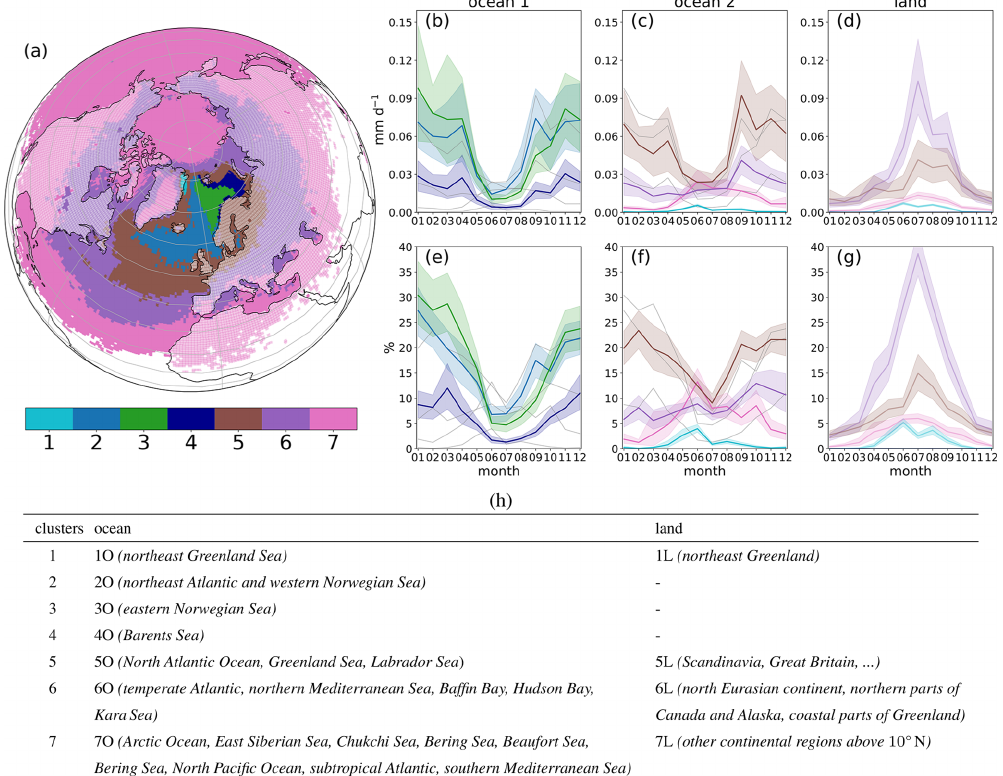
Figure 8. (a) K -means clustering with additional manual separation. The annual cycle of moisture sources contributing to precipitation in the study region is plotted for each cluster in (b) – (d) as absolute number and in (e) – (g) as relative number in percent of the total diagnosed moisture source amount. The ocean (with sea ice) regions in (b) , (c) , (e) , and (f) are separated from the land regions in (d) and (g) , and land regions have more transparent colours in (a) . We use two graphs for the ocean regions for readability; grey lines in (b) , (c) , (e) , and (f) correspond to the missing ocean regions for comparison. Shaded areas represent the 95% confidence interval of the mean. Summing up the different regions of relative contribution for ocean (e, f) and for land (g) would give the total land or ocean (with and without sea ice) contribution shown in Fig. 7d. In (h) , the used cluster abbreviations and descriptions of approximate geographical regions of the K -means clusters of (a) are